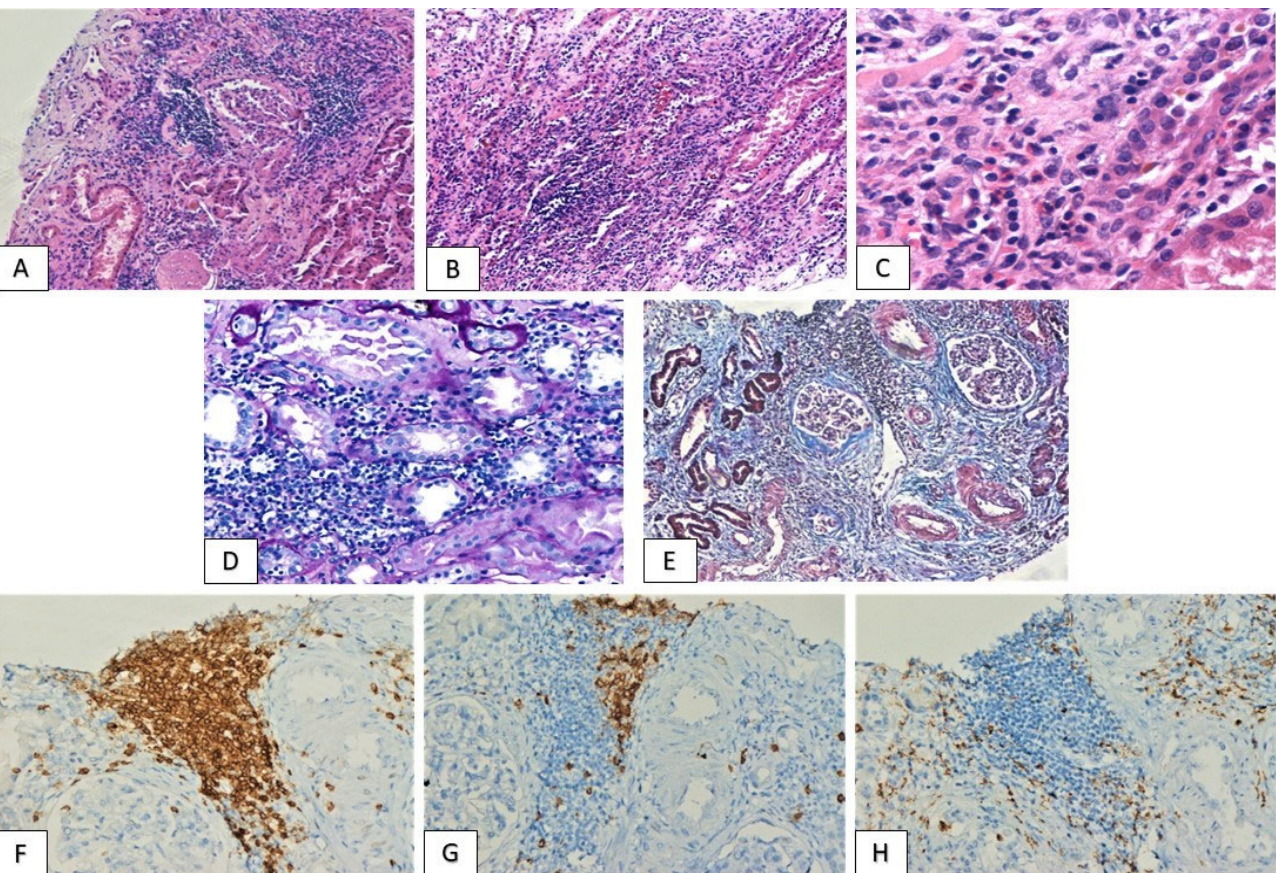
Figure 1. Tubulointerstitial nephritis: focal (( A ): HE ×100) and diffuse (( B ): HE ×100) interstitial inflammation with tubulitis lesions (( D ): PAS ×200) and areas of interstitial fibrosis and tubular atrophy (( E ): Masson Trichrome ×50). Infiltrates are dominated by T ‐ cells (( F ): CD3 ×200), while B ‐ cells are less prominent (( G ): CD20 ×200). Occasional eosinophils (( C ): HE ×400) and scattered macrophages are also detected (( H ): PGM ‐ 1 ×200). Table 3. This table summarizes the chronicity index and the immunofluorescent findings of our patients’ biopsies.